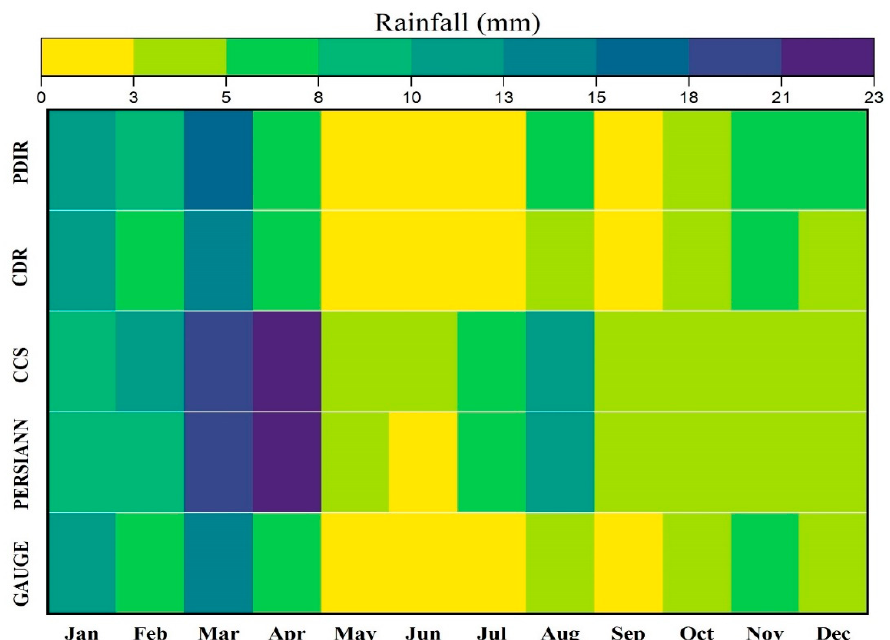
Figure 5. Comparison of mean monthly rainfall values for rain gauges and PERSIANN family products from 2011 to 2020. Months (January–December) are shown on the x-axis.